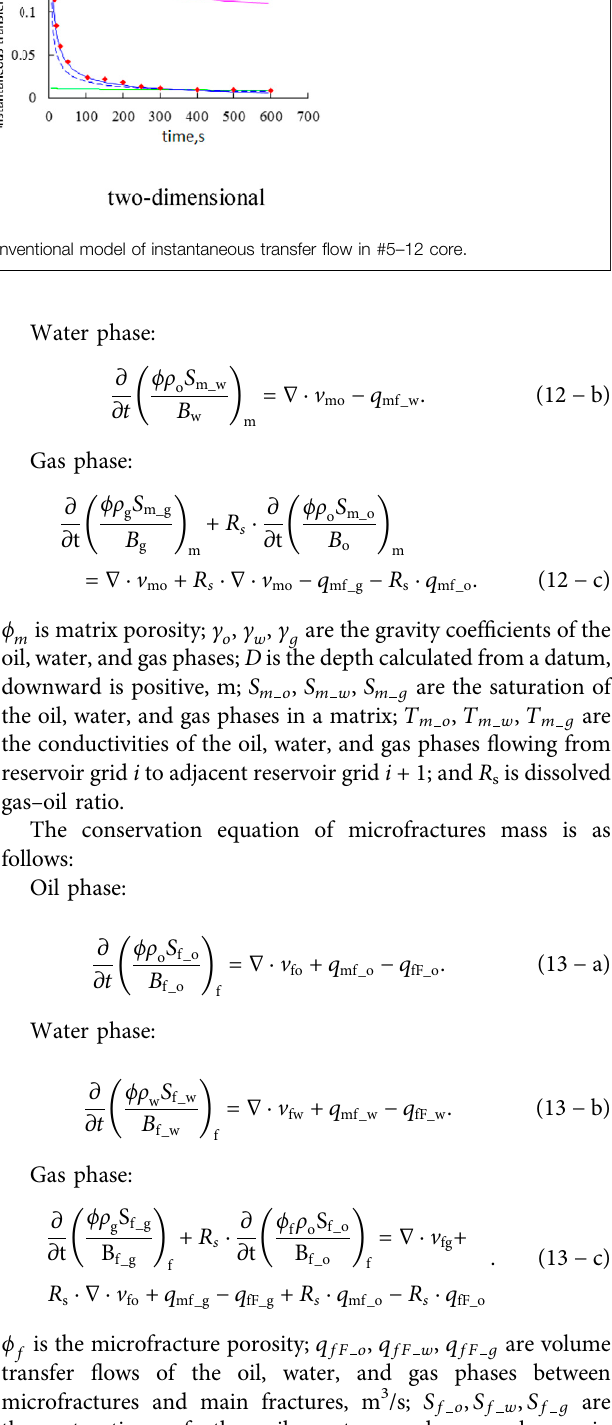
Frontiers in Energy Research |